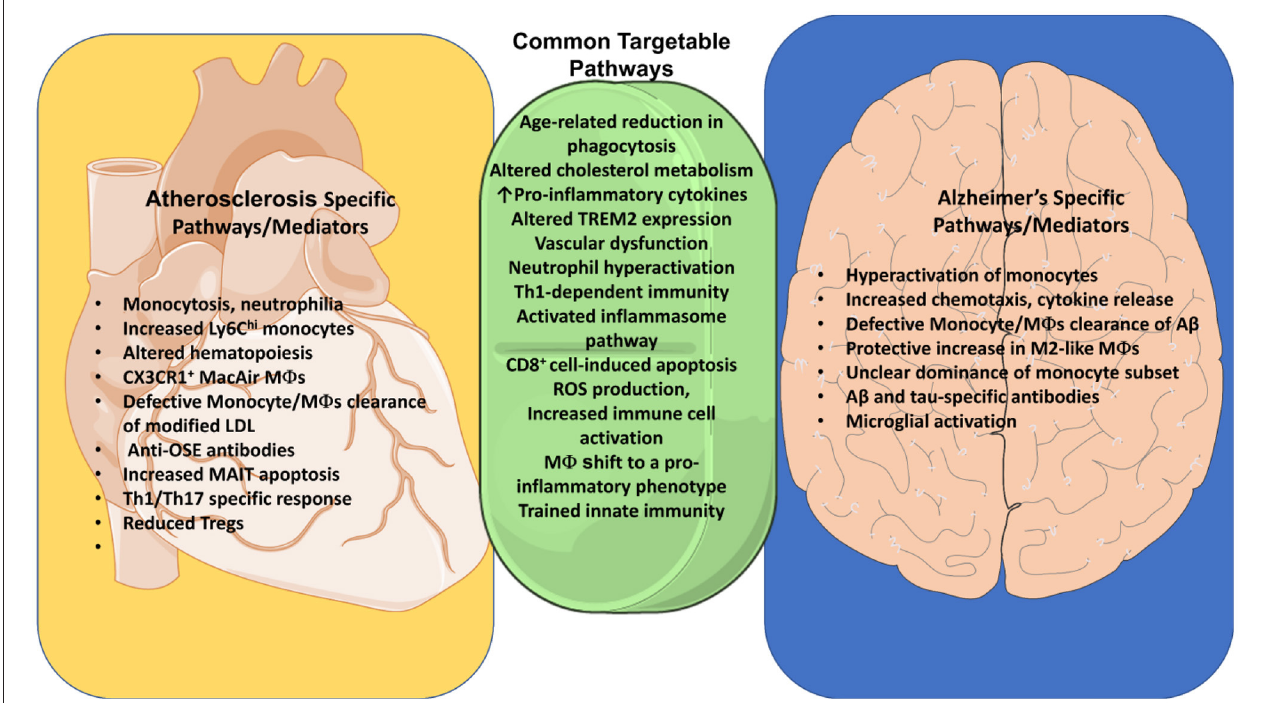
FIGURE 2 | Common pathways of Immune dysregulation between Alzheimer’s and Atherosclerosis. Identification of common pathways between AD and atherosclerosis identifies targets for treatment of both diseases. Both diseases are influenced by an age-related reduction in phagocytosis, as well as cholesterol metabolism, vascular dysfunction, activation of the inflammasome pathway and ROS production. Neutrophil hyperactivation and Th1-dependent immunity are both detrimental to these diseases. TREM2 assists myeloid cells in clearance of A β and cholesterol in their respective diseases. Both diseases also share an increase in IL-4, as well as apoptosis of endothelial cells by CD8 + T cells. We additionally explore differences between these diseases such as the production of OSE-specific antibodies, increased monocytosis, increased Ly6C hi monocytes, increased apoptosis of MAIT cells, and differentiation of Mac AIR macrophages in atherosclerosis. Alzheimer’s, in contrast, features a clearance of A β by monocytes and macrophages, activation of microglia, as well as A β - and tau-specific Abs. Some of these differences may with time be challenged as we uncover more commonalities and ties between these